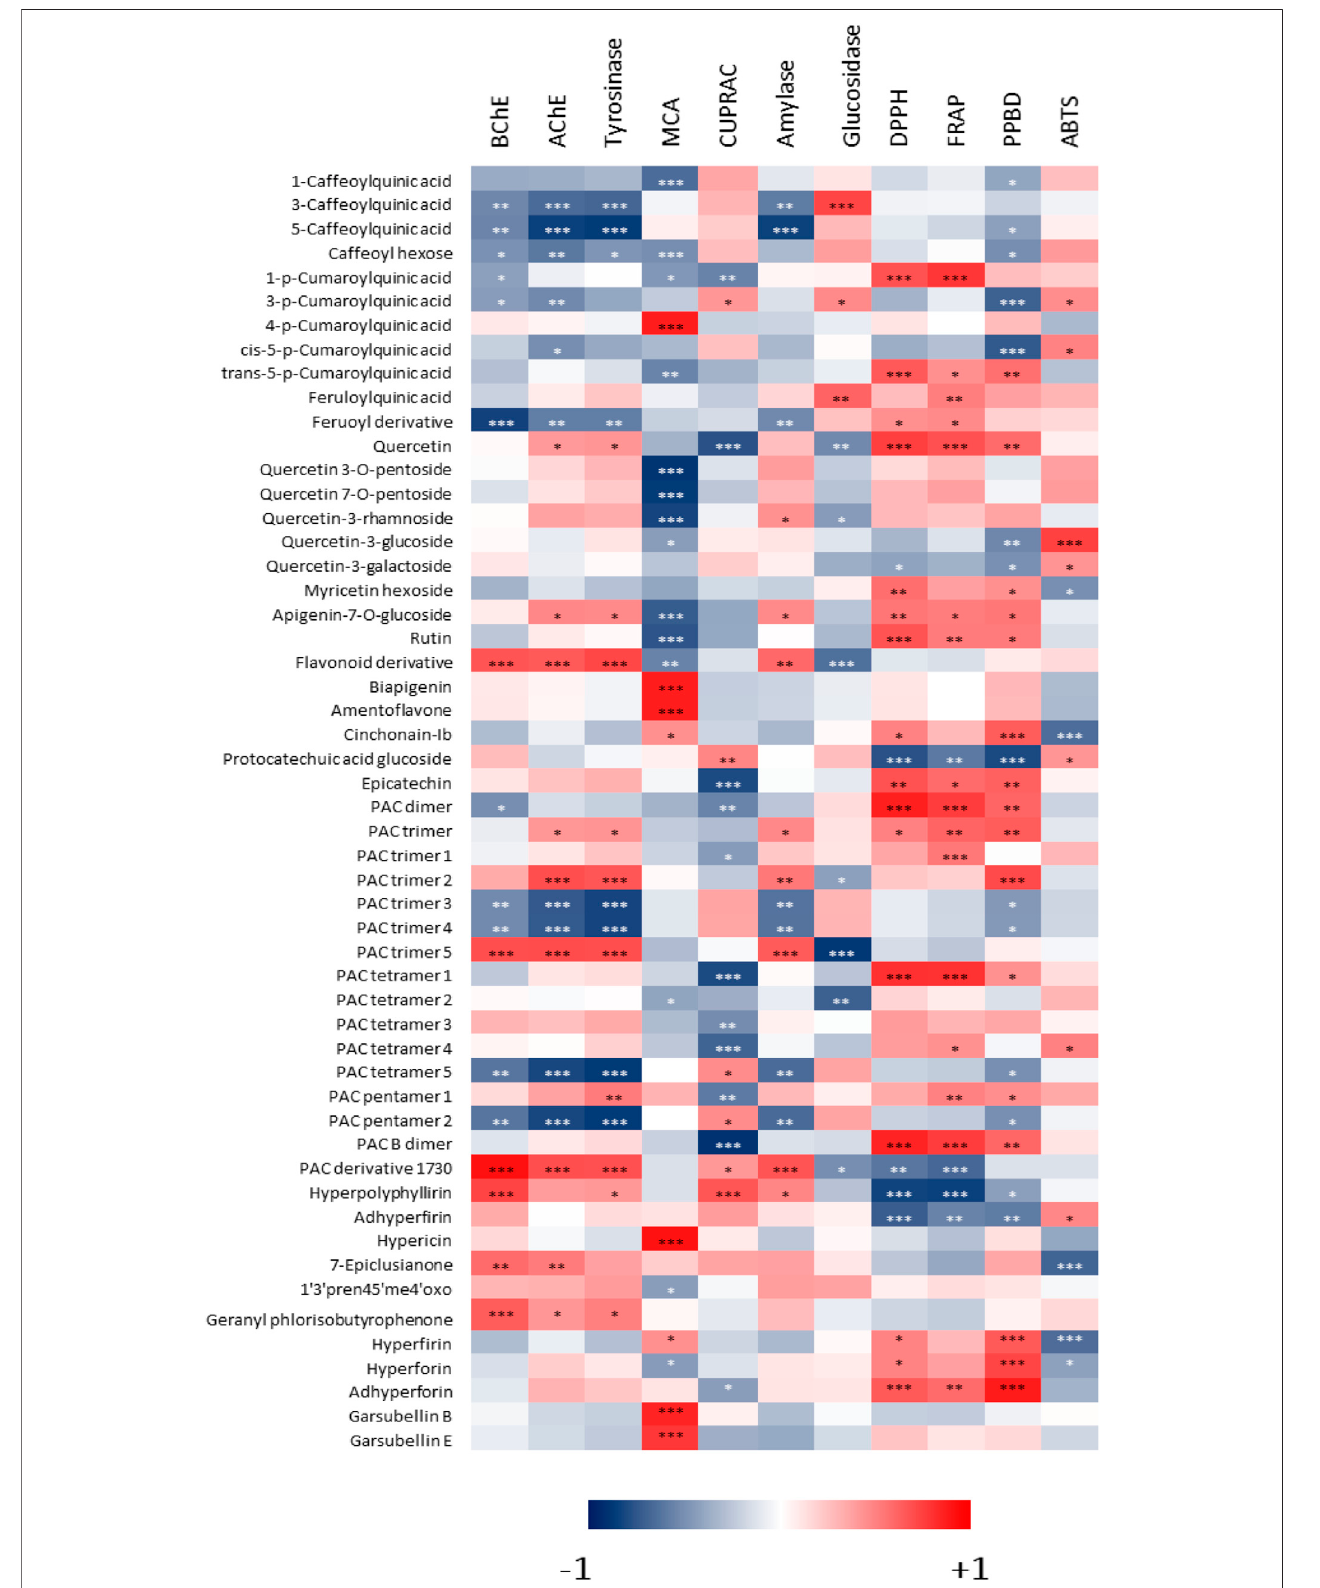
FIGURE6| Heatmapshowingthecorrelationsamongphenoliccompoundsidenti fi edin Hypericum methanolextractsandmeasuredbiologicalactivities.*: p -value < 0.05; **: p -value < 0.01; ***: p -value < 0.001.